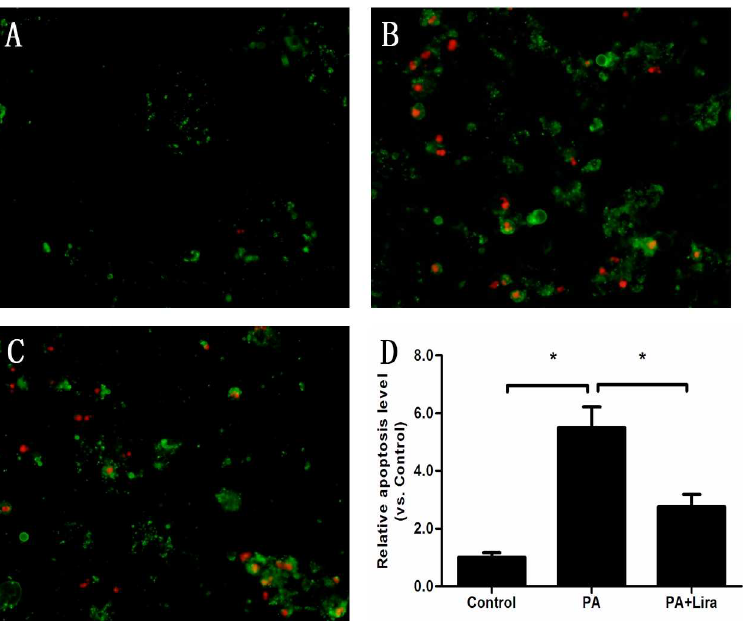
Fig 6. Annexin V and PI staining of INS-1 cells apoptosis treated with vehicel, palmitic acid (0.5 mM) and liraglutide (100 nM). Cells were treated with vehicle(A), palmitic acid (B) or palmitic acid + liraglutide(C) for 48 h, incubatedwith annexinV and PI, and analyzedby confocalmicroscope. Membranes of apoptotic cells were stainedwith annexinV and emitted bright green fluorescence. Nuclei of cells with damagedcell membranes were stainedwith PI and emitted red fluorescence. D: An estimate of the percentageof green- stainedcells. Results are representative of three independentexperiments ( * p < 0.05).